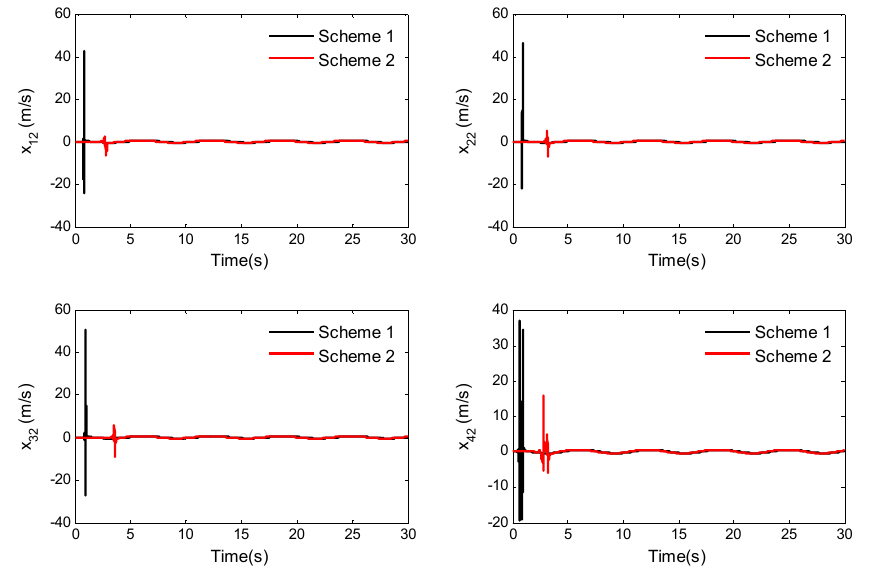
Figure 18. The comparison results of output x i 2